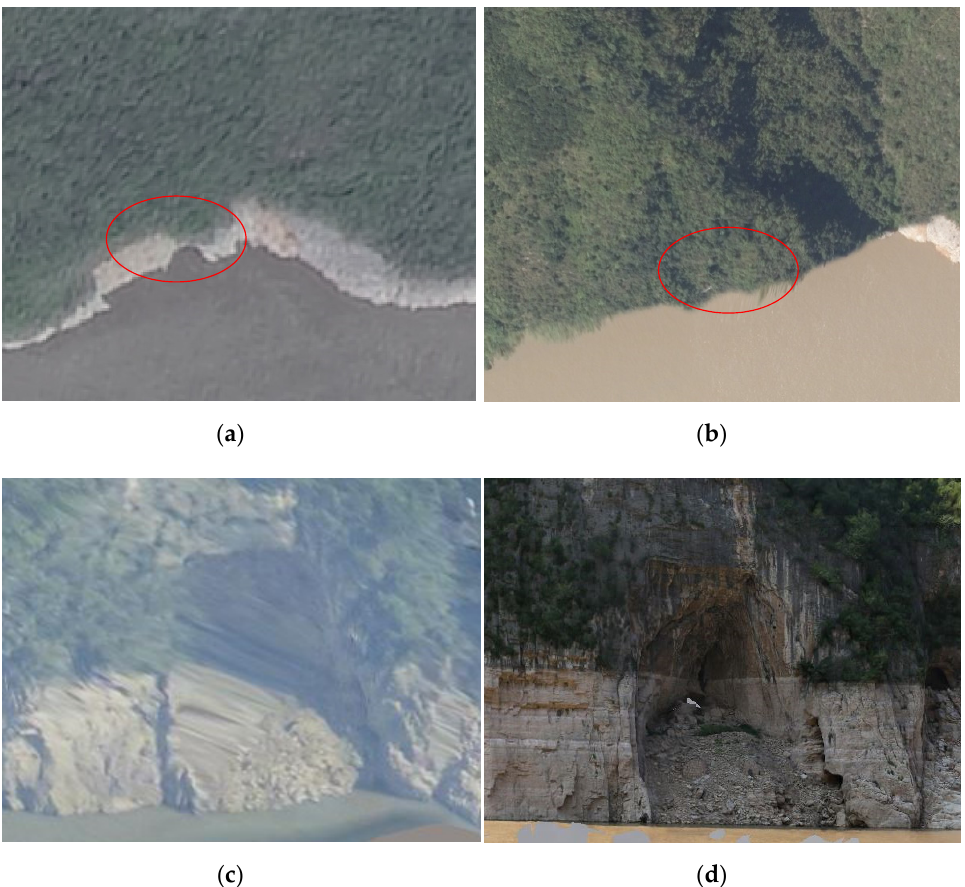
Figure 15. Landslide in the steep terrain area depicted by different remote sensing data. ( a ) GF-2 satellite image; ( b ) aerial orthophotograph; ( c ) oblique photogrammetric 3D model; ( d ) shipborne photogrammetric 3D model. The landslide is located in Wu Gorge. It was impossible to obtain valuable information from either the GF-2 satellite image or the aerial orthophotographs as shown in the red ovals.